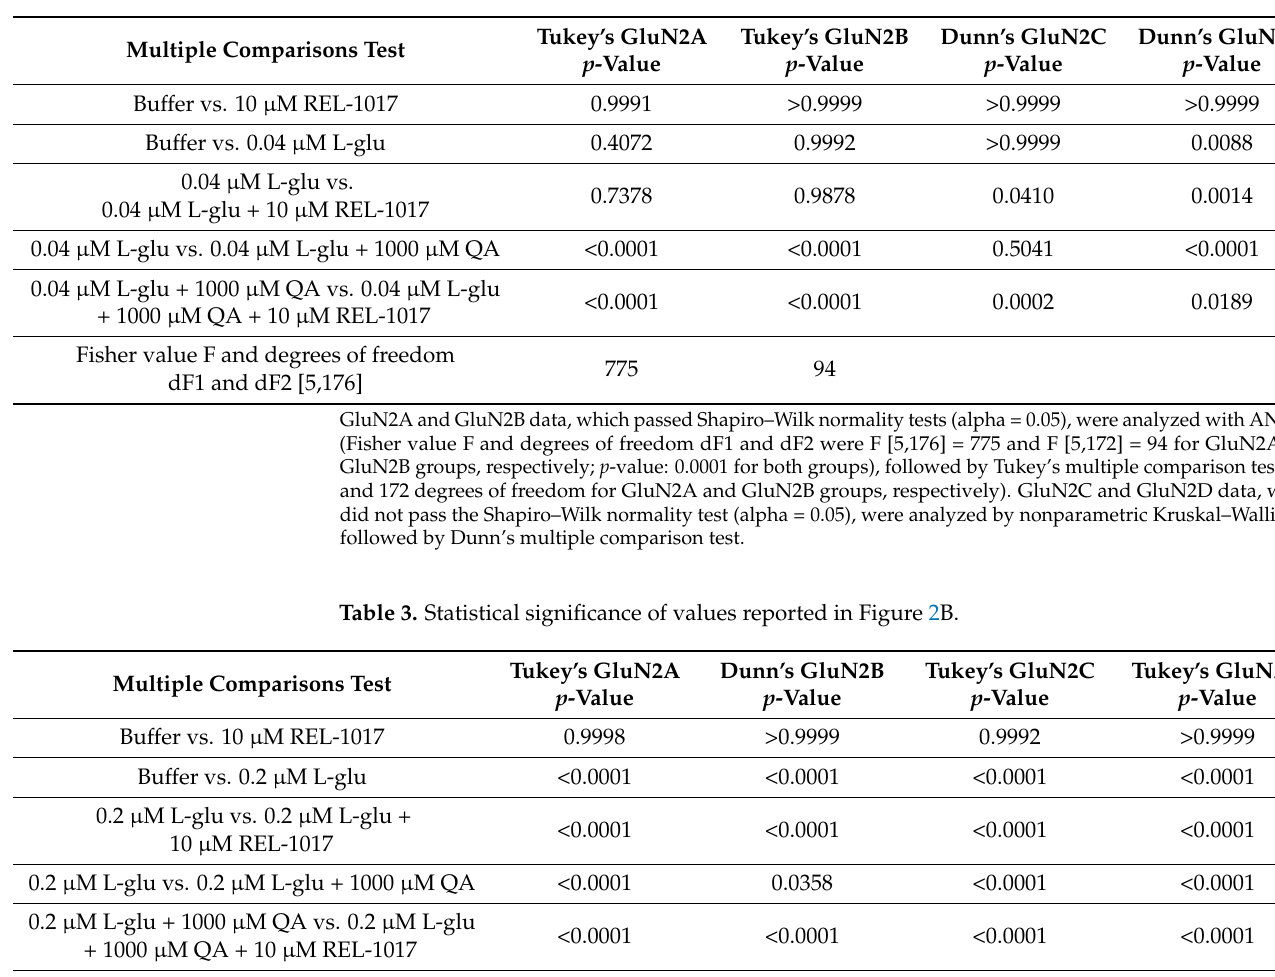
Table 2. Statistical significance of values reported in Figure 2A.